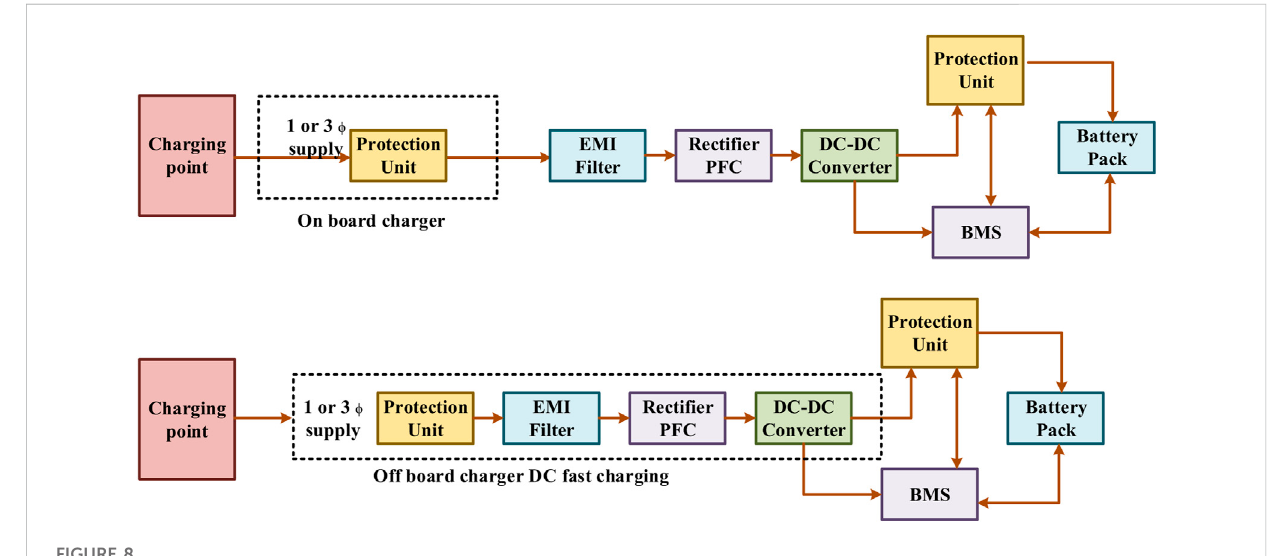
FIGURE 8 On-board and off-board charging facilities.